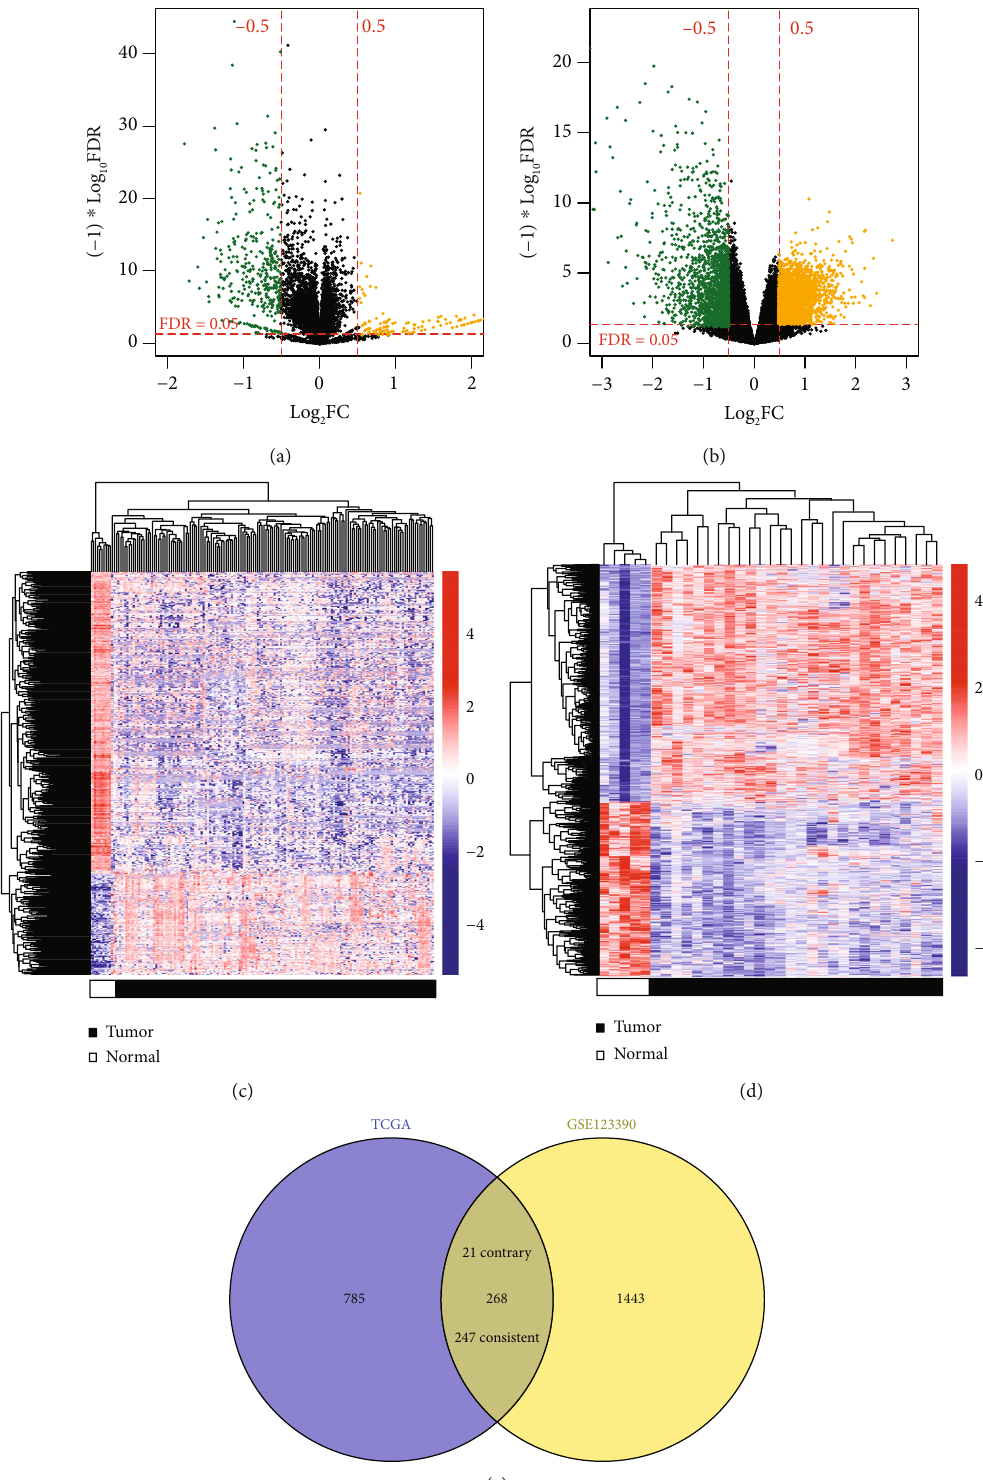
Figure 2: Identi fi cation of di ff erentially expressed mRNAs in two datasets. (a) A volcano plot of di ff erentially expressed RNAs between 162 rectal cancer tissues and 10 normal control tissues of TCGA dataset. (b) A volcano plot of di ff erentially expressed RNAs between 28 rectal cancer tissues and 5 normal control tissues of the GSE123390 dataset. (c) A heat map of di ff erentially expressed RNAs in TCGA dataset. (d) A heat map of di ff erentially expressed RNAs in the GSE123390 dataset. (e) A Venn diagram to display the overlapped di ff erentially expressed RNAs between two datasets. Yellow, high expression; green, low expression. FC: fold change; FDR: false discovery rates; TCGA: The Cancer Genome